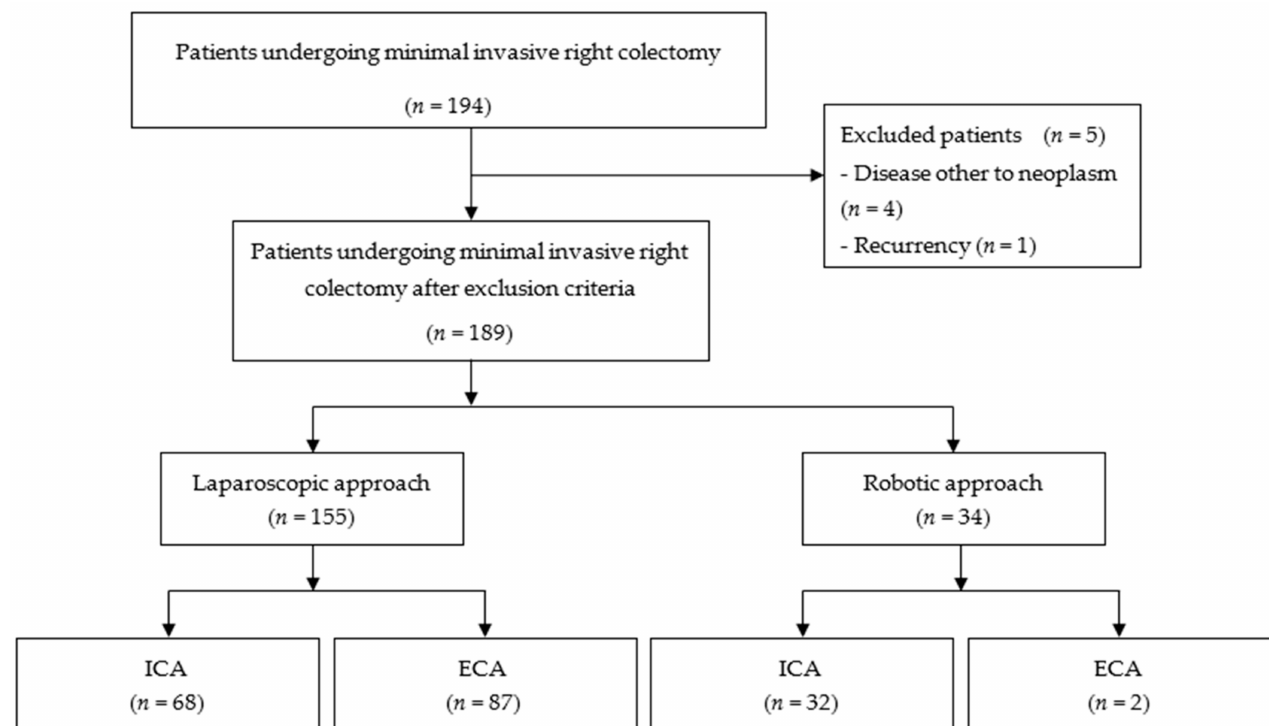
Figure 1. PRISMA flowchart. ICA: Intracorporeal anastomosis; ECA: extracorporeal anastomosis. Global morbidity was higher in patients with EA, with a difference greater than 15% (23.5% vs. 40.2%, p = 0.014) and they had more medical complications (5.9% vs. 14.9%, p = 0.039) (Table 2). No significant differences were found for global surgical complications (17.8% vs. 27.6%, p = 0.1), SSI (2.9% vs. 6.9%, p = 0.31), AL (9.8% vs. 10.3%, p = 0.55), and need for reoperation (7.8% vs. 3.5%, p = 0.14). None of the patients in the IA group had a non-infectious surgical wound complication, compared to 4.6% in the EA group ( p = 0.029). Patients with IA showed a trend toward a reduced incidence of postoperative ileus (10.8% vs. 20.7%, p =